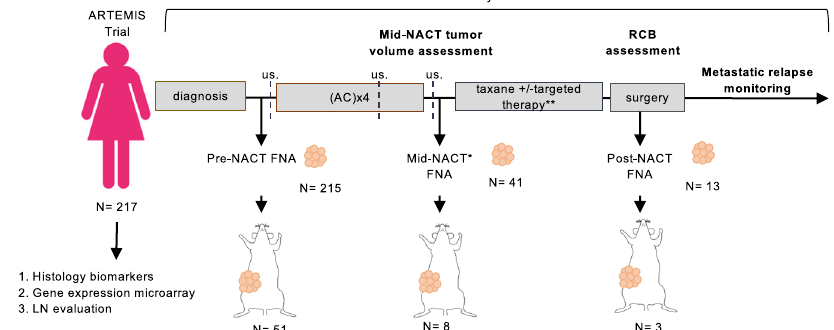
Fig. 1 Establishment of PDX models in alignment with a neoadjuvant clinical trial for TNBC. 217 patients with TNBC were biopsied for PDX generation. Pre-NACT biopsies were stored for FFPE and nucleic acid evaluation. Biopsies for were obtained pre-, mid-, and post-NACT. Tumor volume was measured by ultrasound (us). All biopsies used for PDX engraftment were FNAs. LN, lymph node. Patients with obvious residual tumor mass following four cycles of AC were biopsied for mid-NACT PDX. **Targeted therapies were administered based on pre-NACT biomarker status.